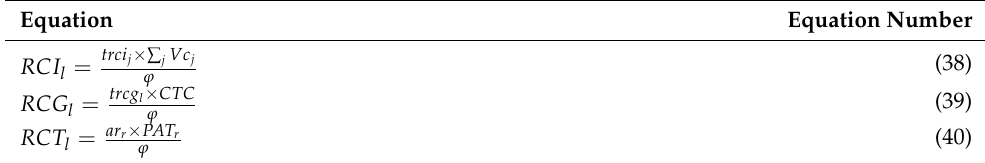
Table 6. Equations that make up the opportunity costs of capital and land that compose the cost calculation model for swine production.